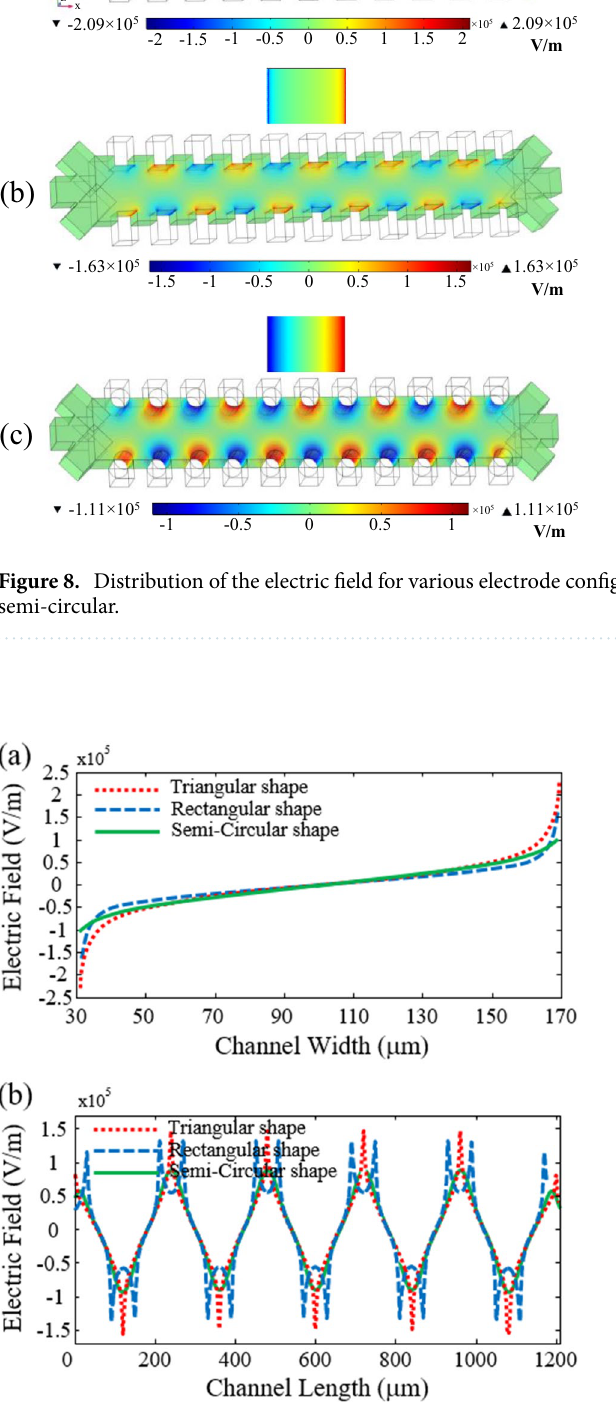
Figure 9. The electric field corresponds to triangular, rectangular, and semi-circular configurations ( a ) in the y-direction ( b ) in the